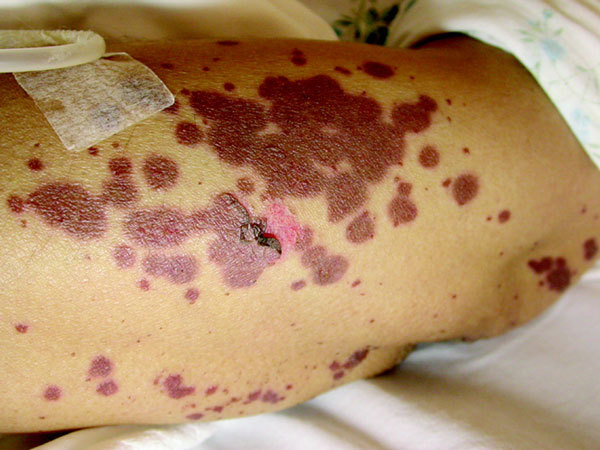
Nikolsky's sign.